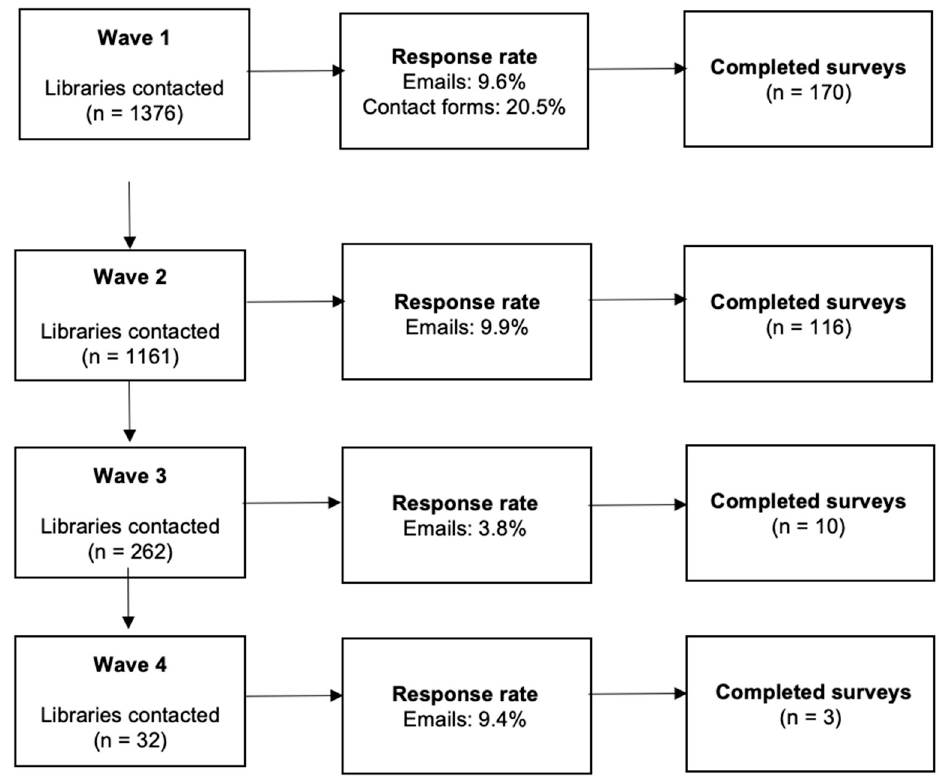
Figure 1. There were 64 libraries for which surveys were completed but zip codes were not available to link the library to its census tract.